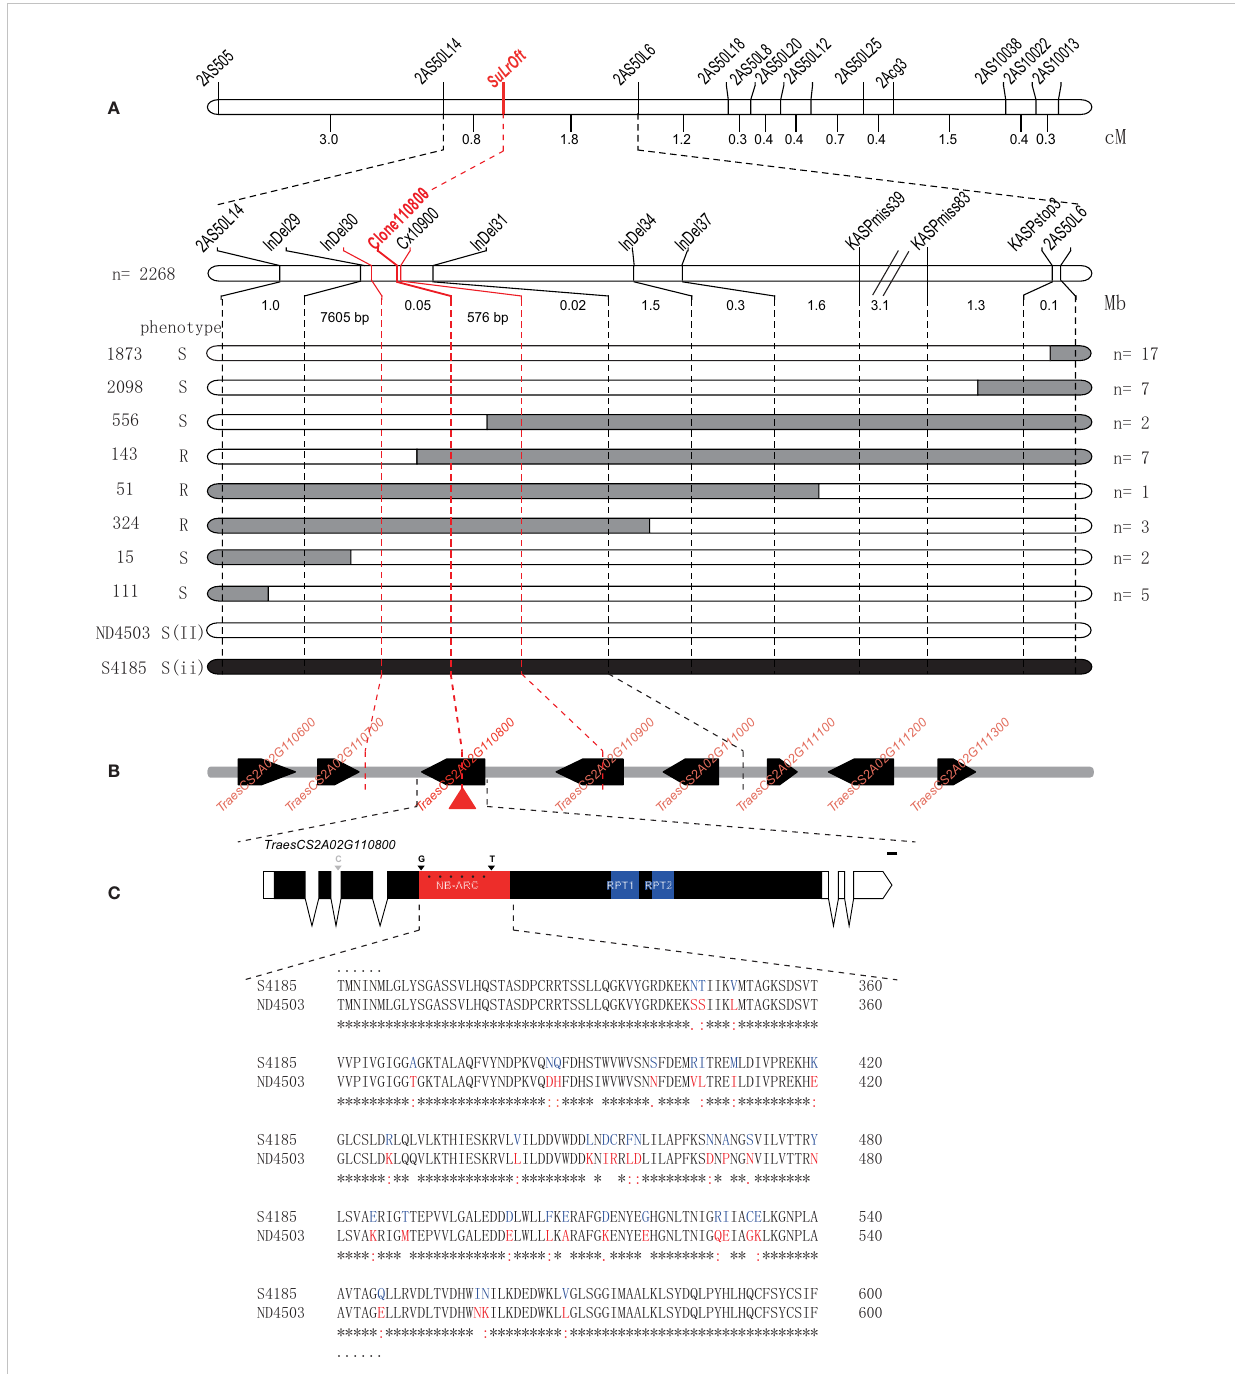
FIGURE 4 Fine mapping of the SuLrOft on chromosome 2AS. (A) Recombinant categories based on disease phenotype and molecular marker genotypes of plants in the three-way cross population. Black and white bars represent the homozygous segments from Shi4185 and ND4503, respectively; (B) annotated genes in the- fi ne mapped region according to the CS IWGSC RefSeq v1.0. The black boxes represent high-con fi dence genes, while arrows indicate the transcriptional orientation of each gene; (C) comparison of protein sequences in Shi4185 and